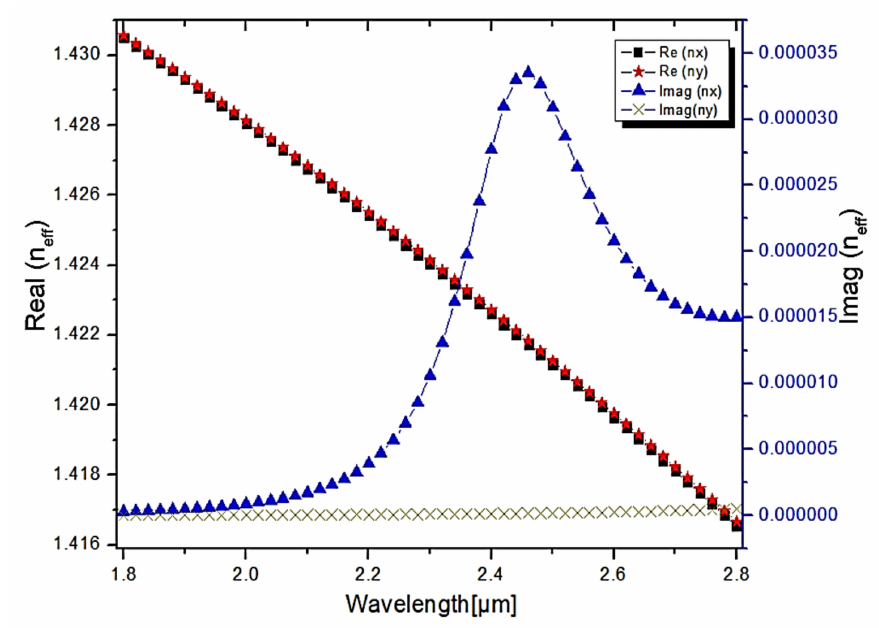
Figure 11. Real and Imaginary values of 1.36